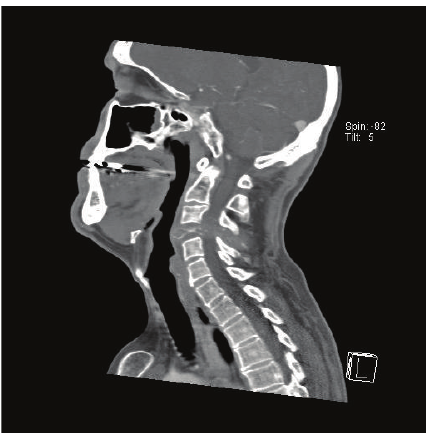
Figure 1: CT of the neck demonstrating erosive metastatic tumor of the C4 vertebral body.